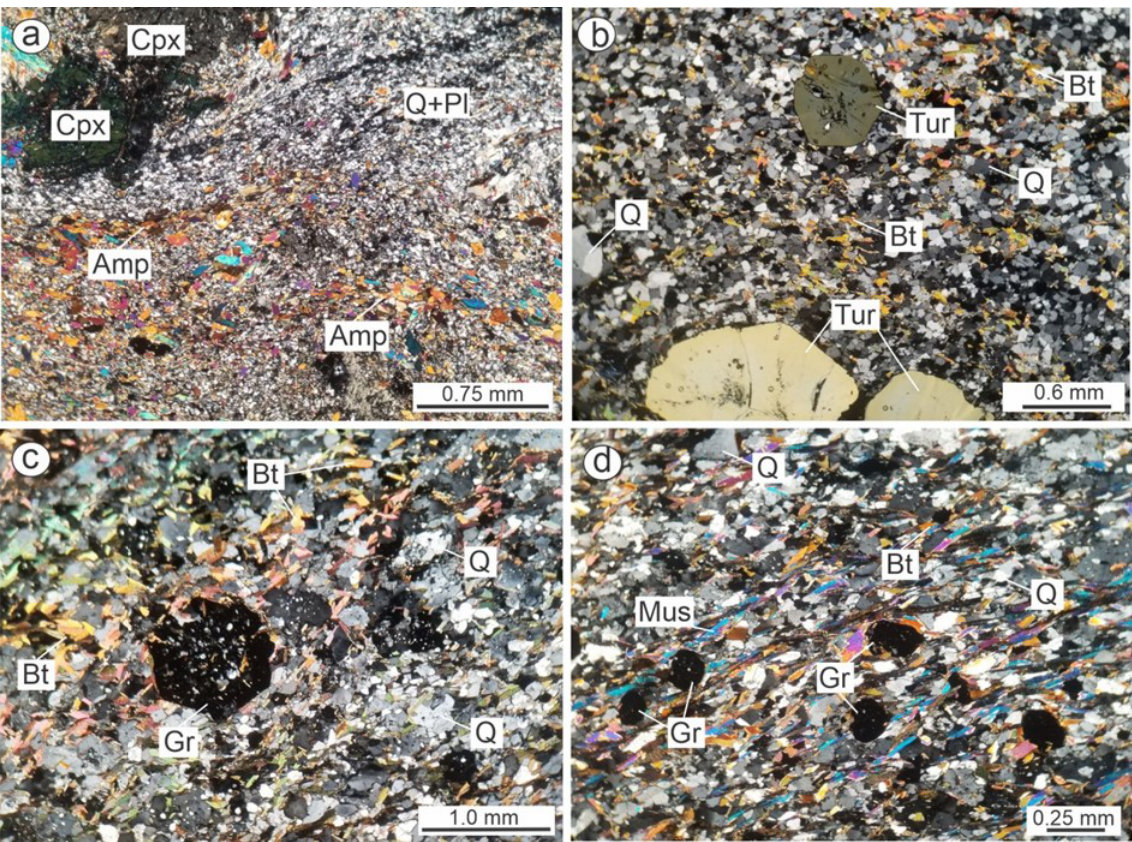
Fig. 4. Representative microphotographs of metamorphic rocks from the Khaychin Gol area. a) Hornblende schist (sample O40), b) Biotite-plagioclase gneiss (sample O42/1), c) Biotite-quartz-plagioclase schist (sample O38/1), d) Two-mica quartz schist (sampe O37/3), Abbreviations: Q – quartz, Pl – plagioclase, Amp – amphibole, Tur – tourmaline, Gr – garnet, Bt – biotite, Mus – muscovite. All photomicrographs are under cross-polarized